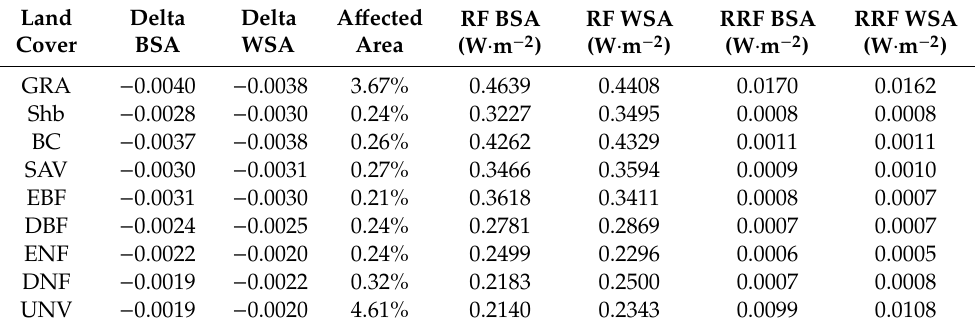
Table 2. Radiative forcing (RF) and Relative radiative forcing (RRF) induced by the black-sky albedo (BSA) and white-sky albedo (WSA) trend over mountainous terrain at TP from 2001 to